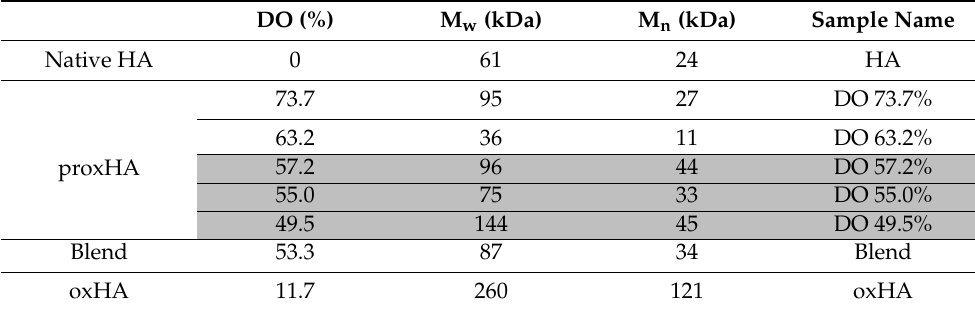
Figure 1. Determination of degree of oxidation (DO) via NMR: ( a ) NMR spectrum of tert -butyl hydrazine modified HA measured in D 2 O; ( b ) comparison of TEMPO/TCC and NaIO 4 oxidized HA in their DO. Table 1. DO in %, weight and number average molecular weights (M w and M n in kDa) of native HA, oxHA, and various batches of proxHA synthesized with 0.25 eq. of TCC. Grey marked batches were combined to one